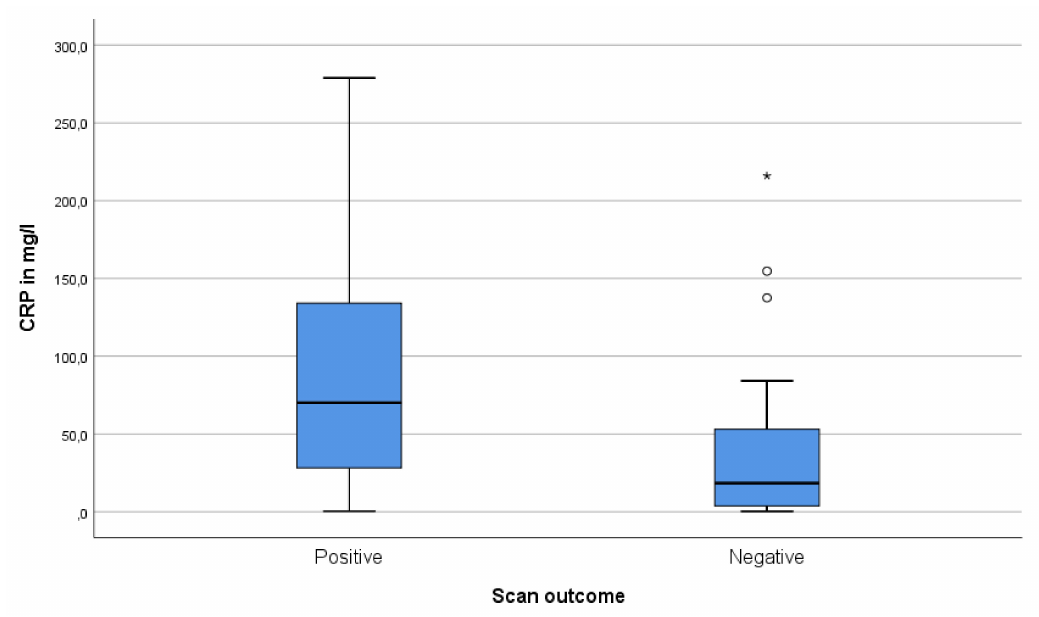
Figure 4. CRP measured less than a week before FDG-PET / CT scan in children with positive and FDG-PET / CT negative FDG-PET / CT scans (both first diagnostic and follow-up scans, n = 54 (59 patients, of which five were without documented CRP measurement the week before PET / CT scan; three in the positive scan group and two in the negative scan group). The bar indicates the median CRP, the box indicates the interquartile range (IQR), and whiskers indicate the range. Open circles represent outliers > 1.5 * IQR and an asterisk represents an outlier > 3 *